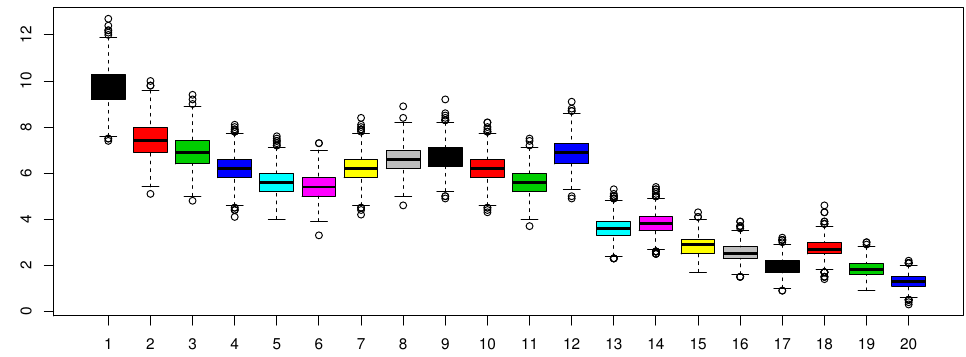
Figure 7. Campania, bootstrapped observations referring to 1986. Distribution of the number of meteorological stations in each of the 20 temperature